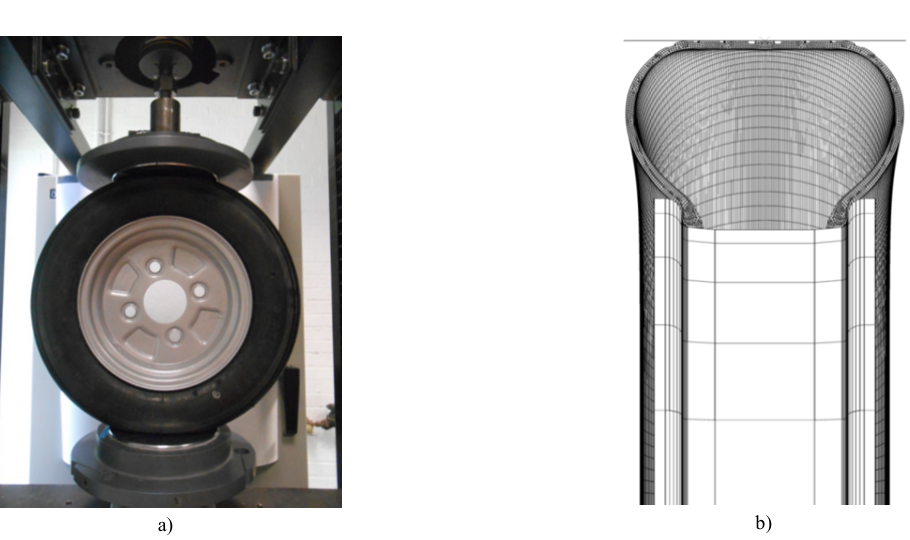
Fig. 6 Compression test of bias-ply tyre at 1 mm/min: a) Experiment and b) Cut view of simulation.